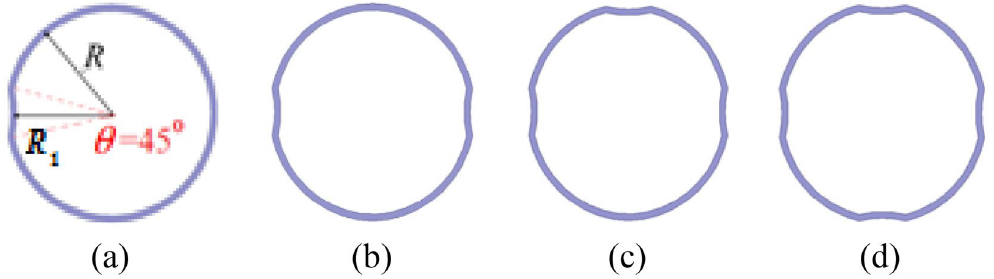
Figure 4. ( a ) one- ( b ) two- ( c ) three- ( d ) four-directions of winding radial